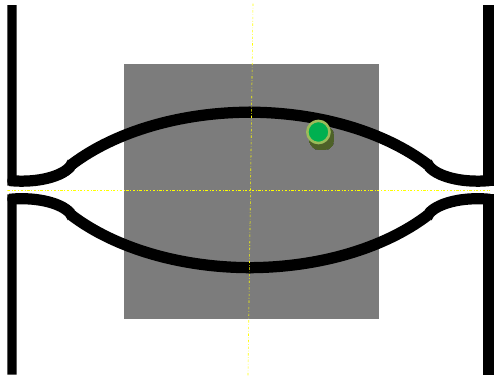
Figure 24. Location of modeling point.